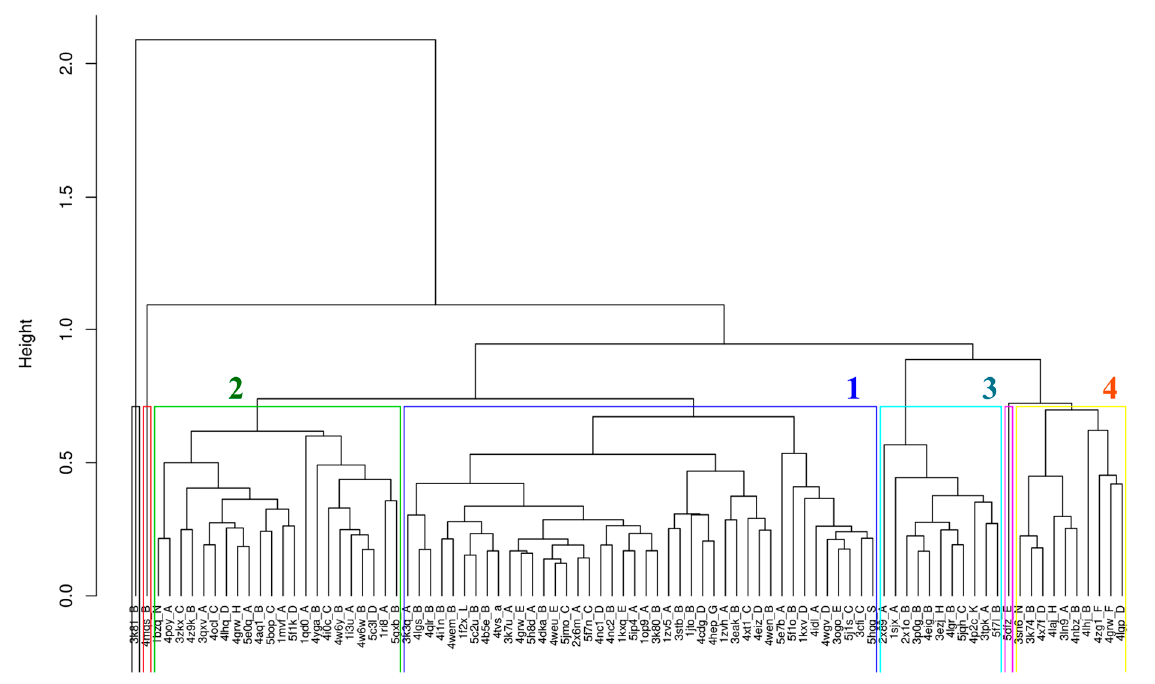
Figure 5. Hierarchical clustering of V H H trajectories using RMSF. The different RMSF clusters are demarcated using coloured boxes, and their cluster number is marked accordingly.